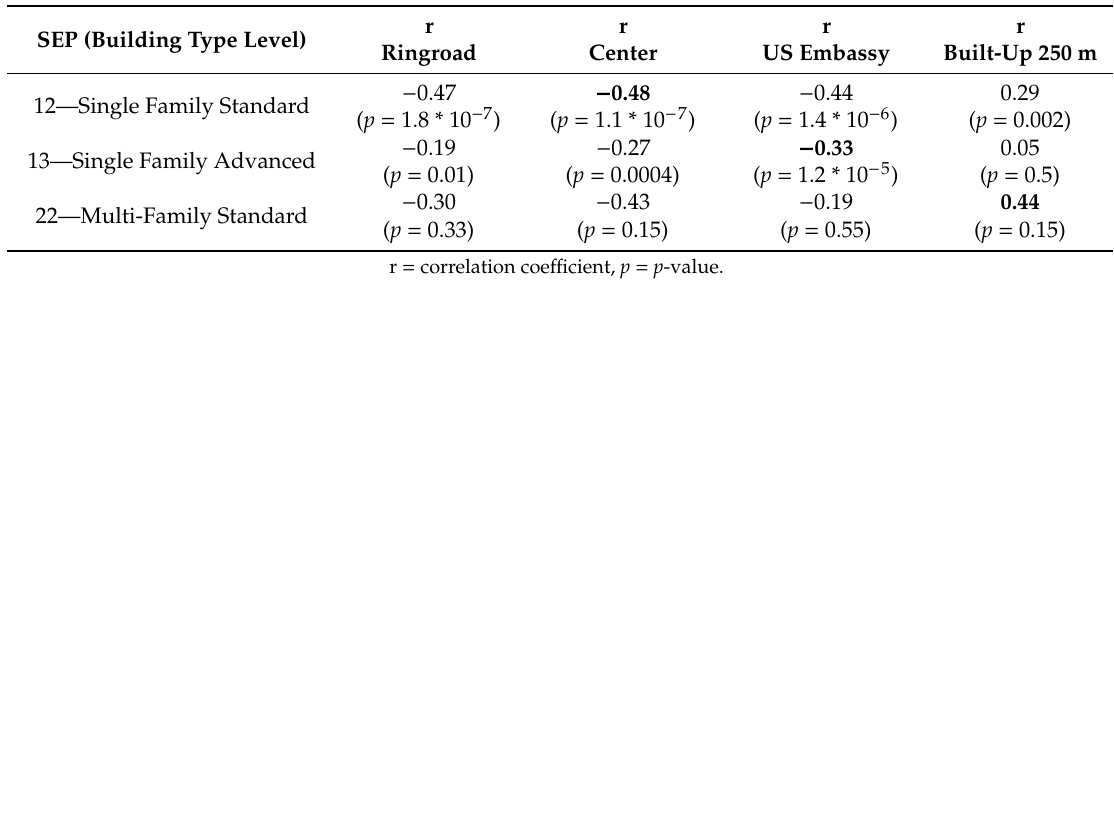
Table A1. Relation between distance from buildings to point urban centrality to socio-economy on building type level.